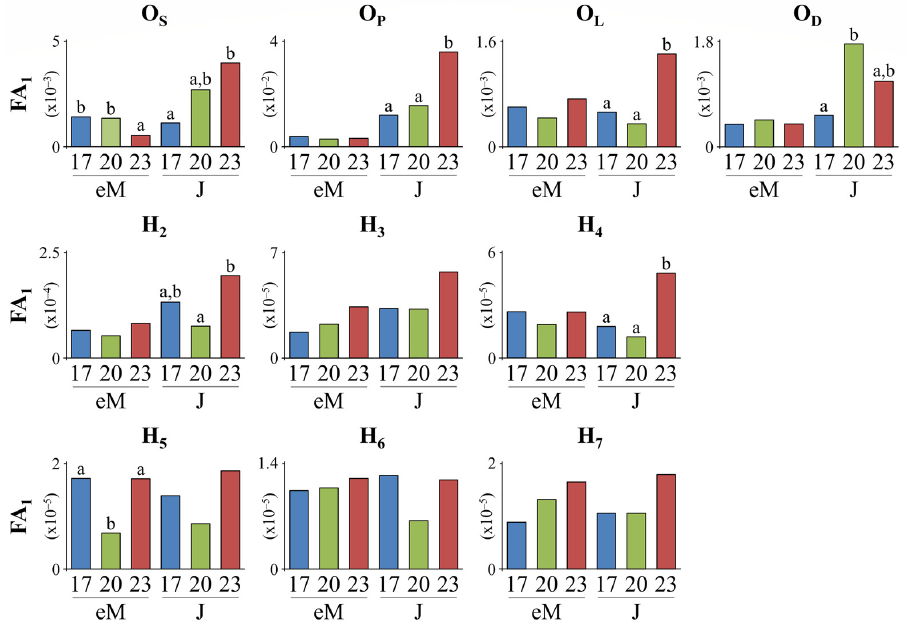
Figure 6. Effect of developmental temperature (17, 20, and 23 ◦ C) on seabream otolith asymmetry (index FA 1 ) at the end of metamorphosis (eM, 56–58 days post-hatching, dph) and early juvenile stage (J, 93–95 dph). For each developmental period (eM, J), values without a letter in common are statistically different ( p < 0.05, F-test). Table 2. Estimates of skew (g1) and kurtosis (g2) of otolith asymmetry values (R-L) for surface (O S